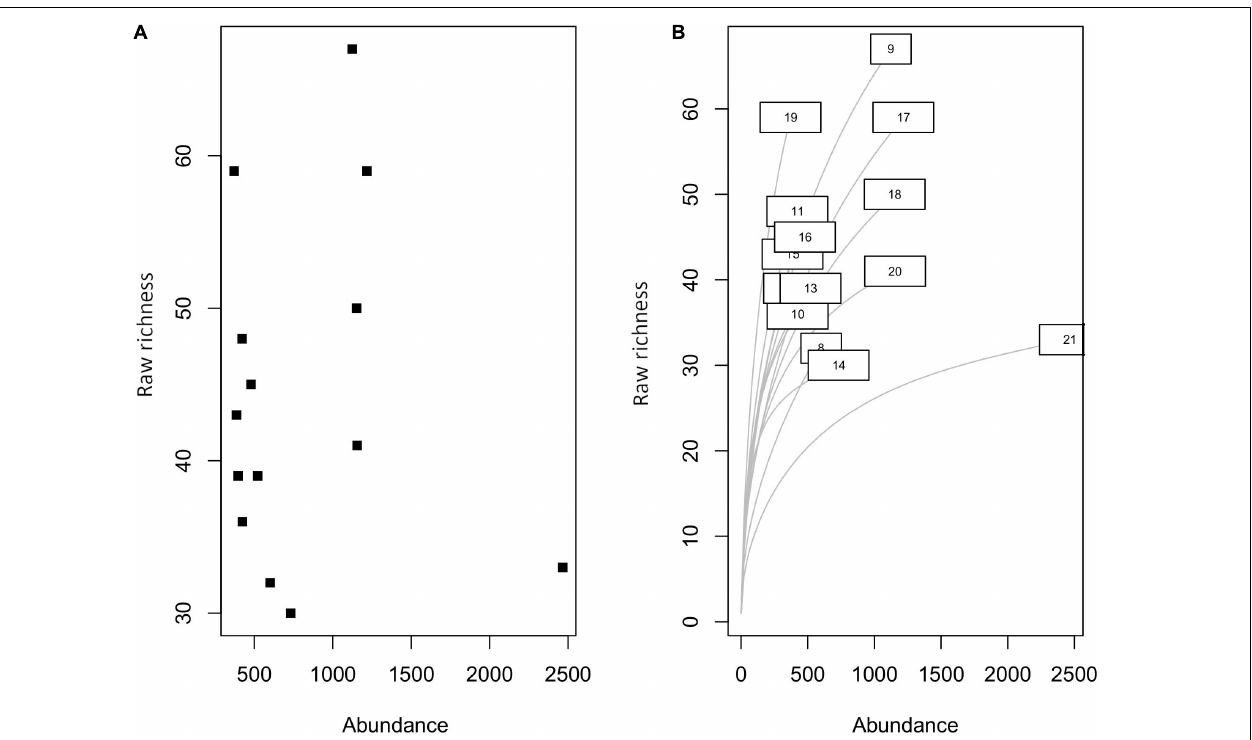
FIGURE 2 | (A) Relationship between species richness and abundance. (B) Rarefied species richness at different latitude bins. TABLE 2 | Summary of the diversity of marine bivalve families and functional groups along with their correlation with latitude.